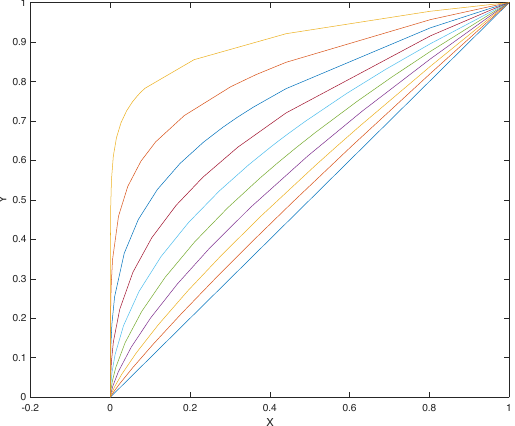
Figure 40. Trajectories x , y assuming a slower behaviour in y coordinate than for x coordinate, px > py . The trajectories were generated considering that the poles start to be located at the same point in relation to the origin p x = p y and then p x moves away from the origin in percentages of 10 percent making the behaviour in coordinate x faster than the behaviour in y coordinate.